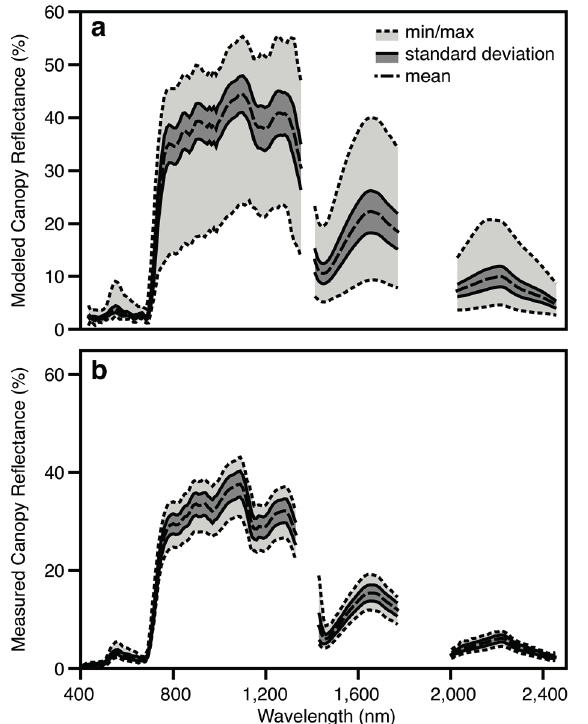
Figure 6. ( a ) Simulated canopy reflectance calculated using all leaf spectra (Figure 4) with a canopy radiative transfer model and a random selection of canopy structural properties (Table 2). ( b ) Actual forest stand-level reflectance spectra from 79 one-hectare field plots in the Amazon basin. The thick dashed line indicates mean values; dark grey areas indicate one standard deviation; light grey areas indicate the total range of